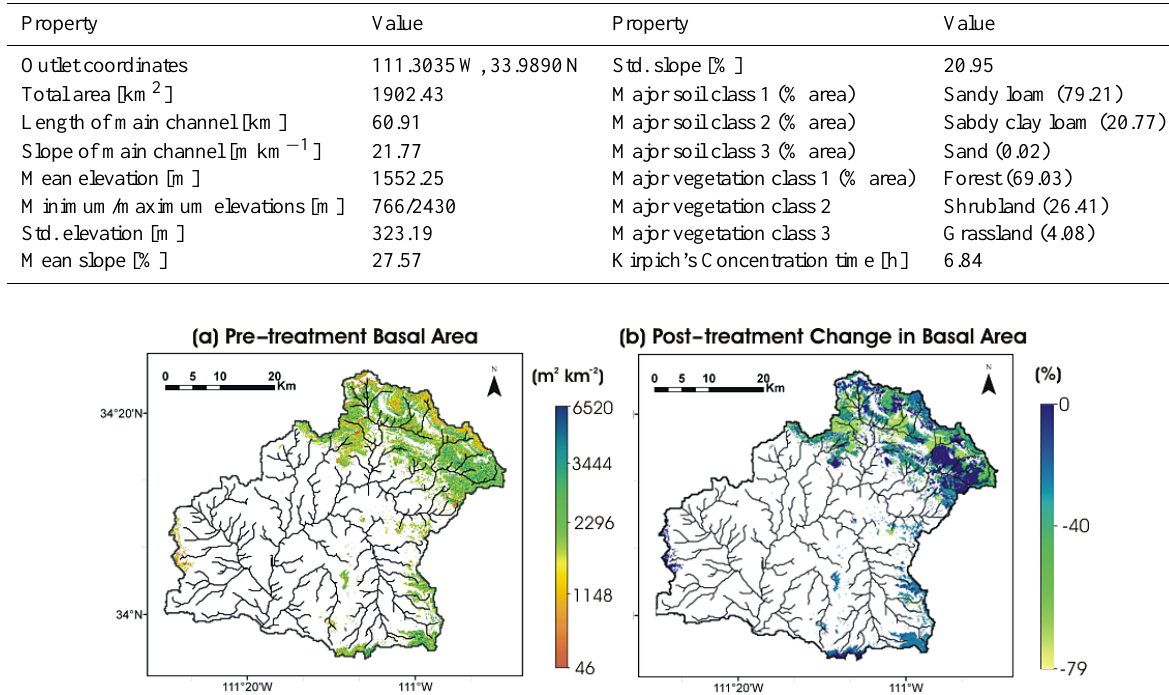
Table 1. Topographic, soil, vegetation and bedrock characteristics of the Tonto Creek basin.